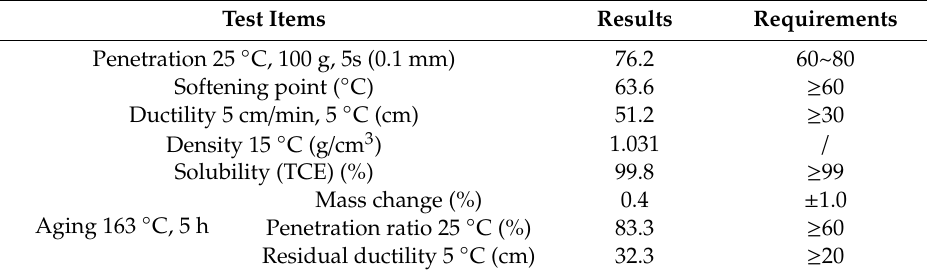
Table 1. Physical properties of the SBS asphalt binder.